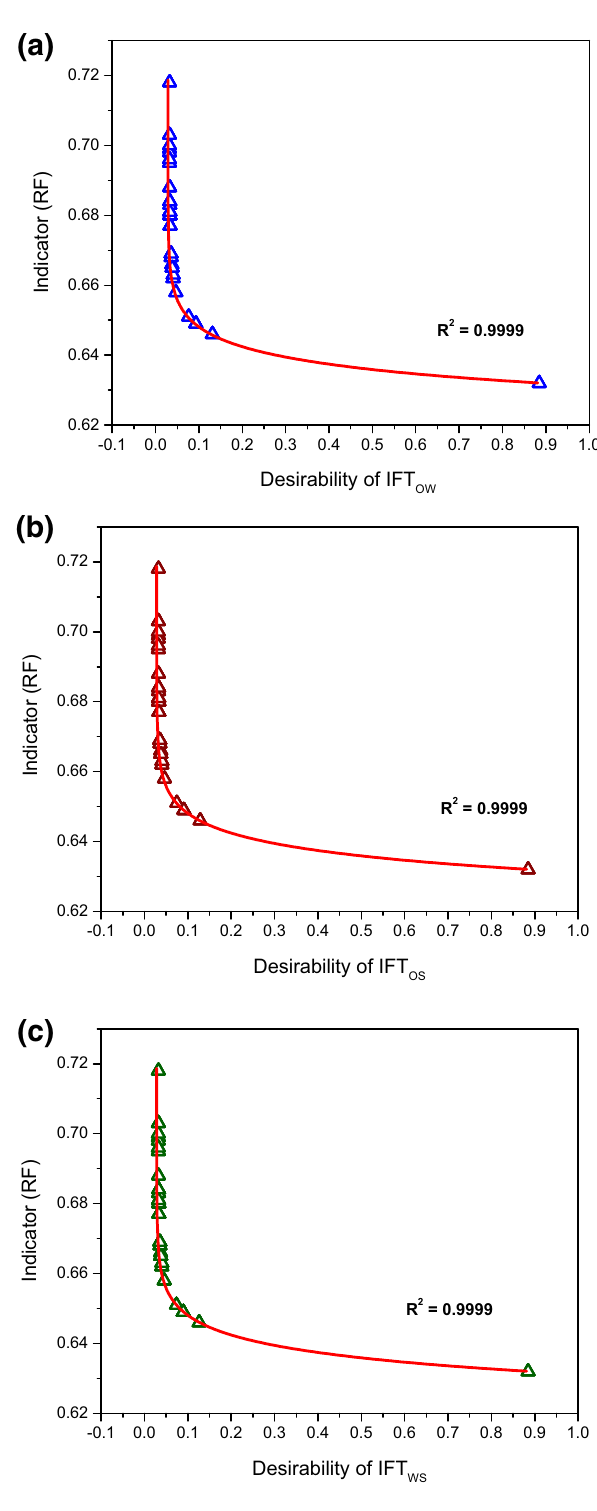
Fig. 5 Individual desirability ( d i ) of a oil-aqueous interfacial tension, b oil-solid interfacial tension and c solid-aqueous interfacial tension to the recovery factor (RF) as an assessing indicator. All lines are exponential curve fit